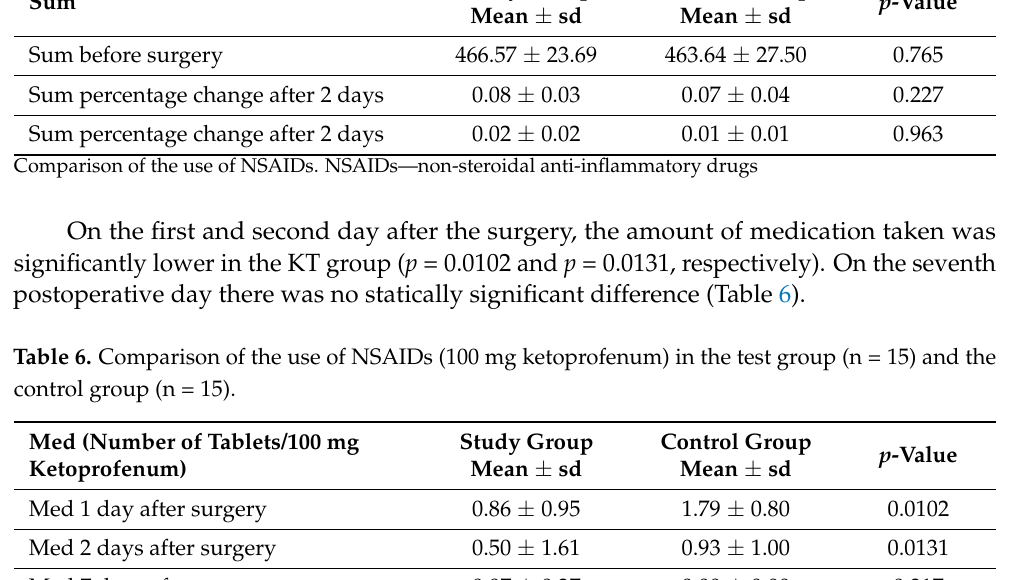
Table 5. Comparison of the facial tissue swelling in the test group (n = 15) and the control group (n = 15). Sum